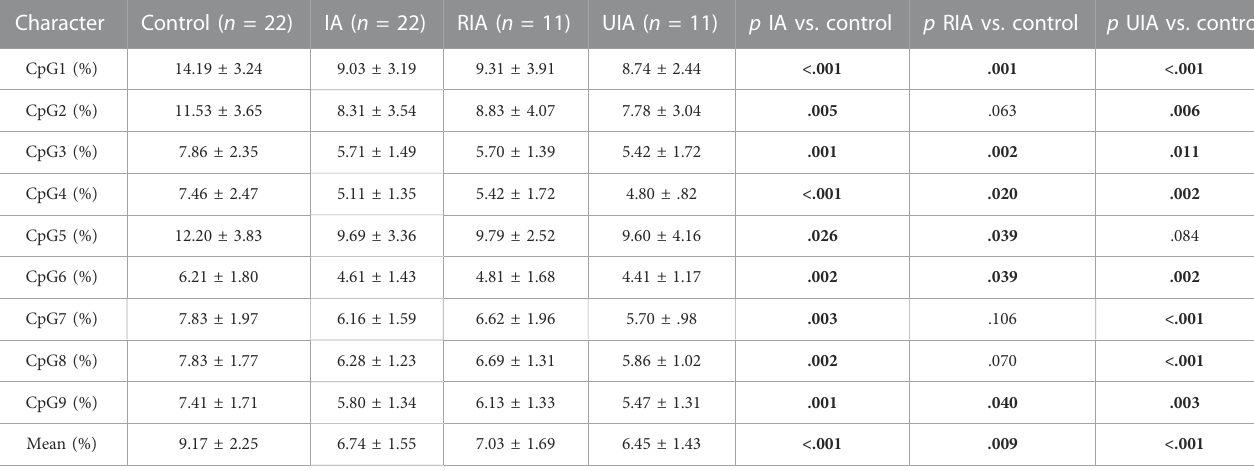
TABLE 3 DNA methylation differences of nine CpGs dinucleotides of GSTA4 gene between IA and control in women. Character